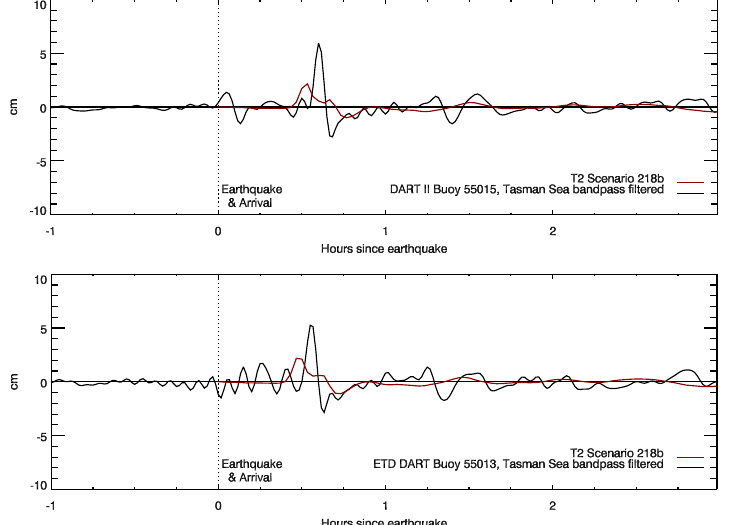
Fig. 13. Comparison of nearest T2 scenario for the Puysegur 2009 event with observations from Tsunameters 55015 (top) and 55013 (bottom), situated in the Tasman Sea. A description of how the tsunameter observations have been processed is in the text.